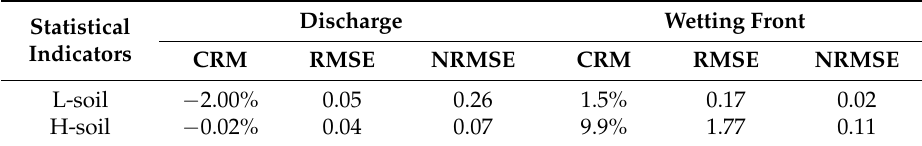
Figure 3. Graphs showing the measured and simulated emitter discharge and wetting front. Table 2. Statistical indicators of measured and simulated discharge and wetting front in two different